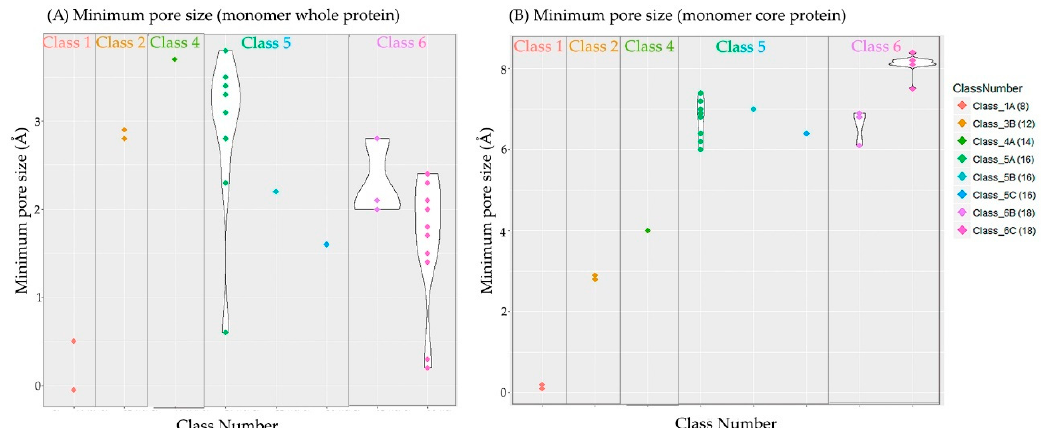
Figure 4. Estimated minimum Angstrom pore size radius for each subclass using the HOLE software [37]. Each colored diamonds represent one monomer structure. ( A ) Whole structure; ( B ) core structure where loops and turns were removed. The barrel size number of strands in each β -barrel) is listed in brackets next to the class name labels.